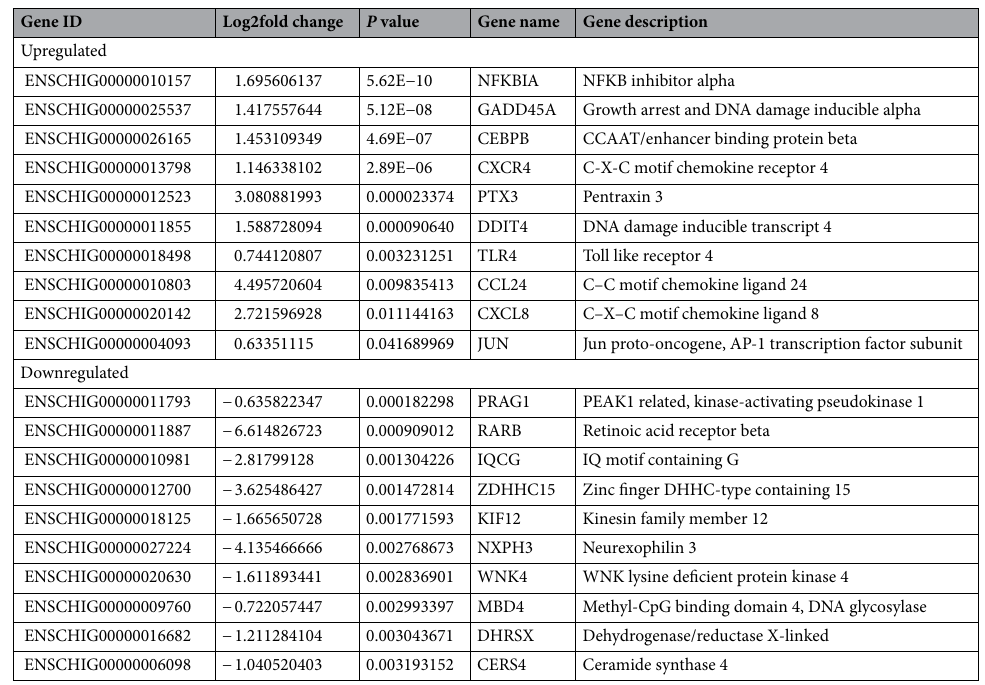
Table 3. Differentially expressed genes (DEG) in blood samples of goats transported for 30 min vs. goats not transported (control).